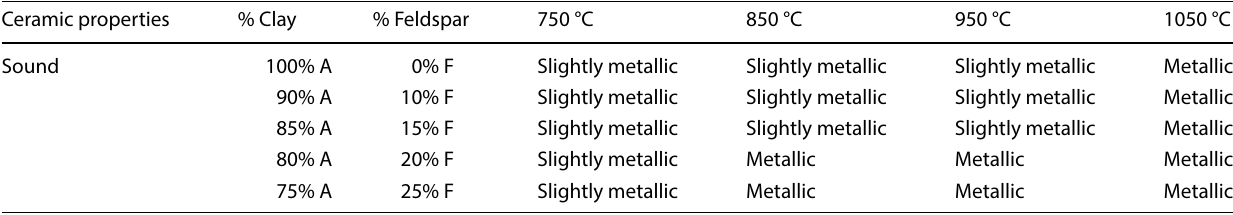
Table 4 Sound transmission of bricks after firing Ceramic